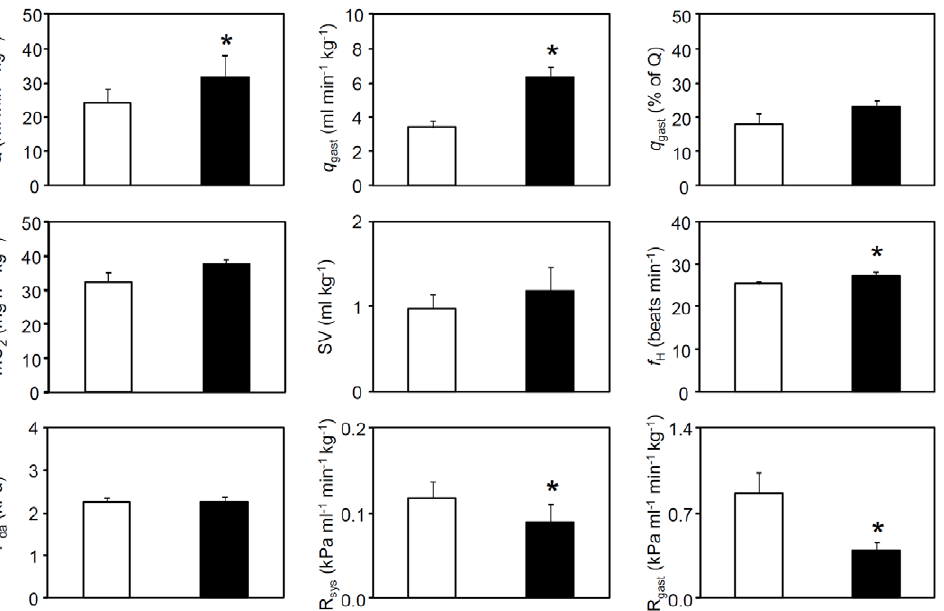
Figure 2. Cardiorespiratory status before and after feeding. P. borchgrevinki were force fed with fish white muscle amounting to , 2% of body mass. Open bars are unfed fish (N=9–14) and closed bars are 24 h after feeding (N=5–8). The variables are cardiac output (Q), gastrointestinal blood flow (q gast ), oxygen consumption (MO 2 ), stroke volume (SV), heart rate ( f H ), dorsal aortic blood pressure (P da ), systemic vascular resistance (R sys ) and gastrointestinal vascular resistance (R gast ). Values are means ( + S.E.M.) and * denotes significantly different value (p , 0.05) from the unfed control.